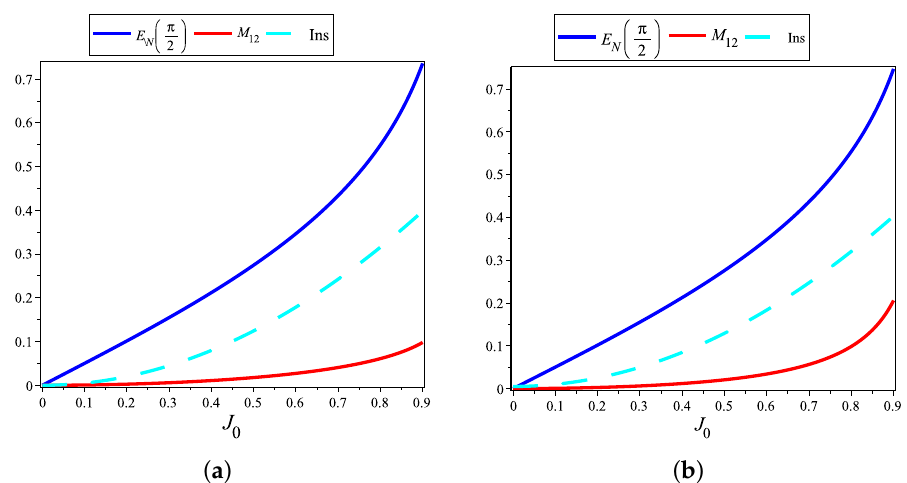
) , geometric average of excitations 2